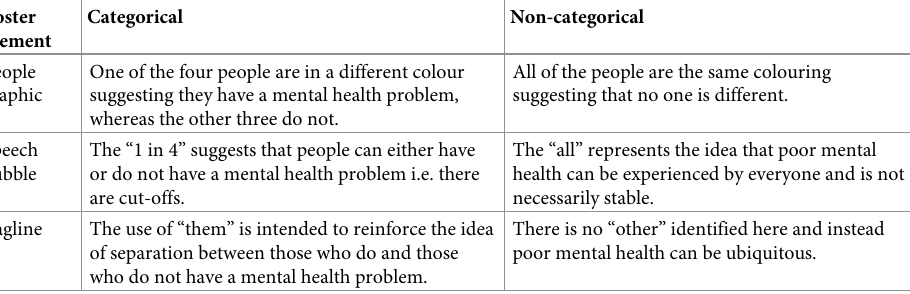
Table 1. Details of how the anti-stigma posters differed between experimental